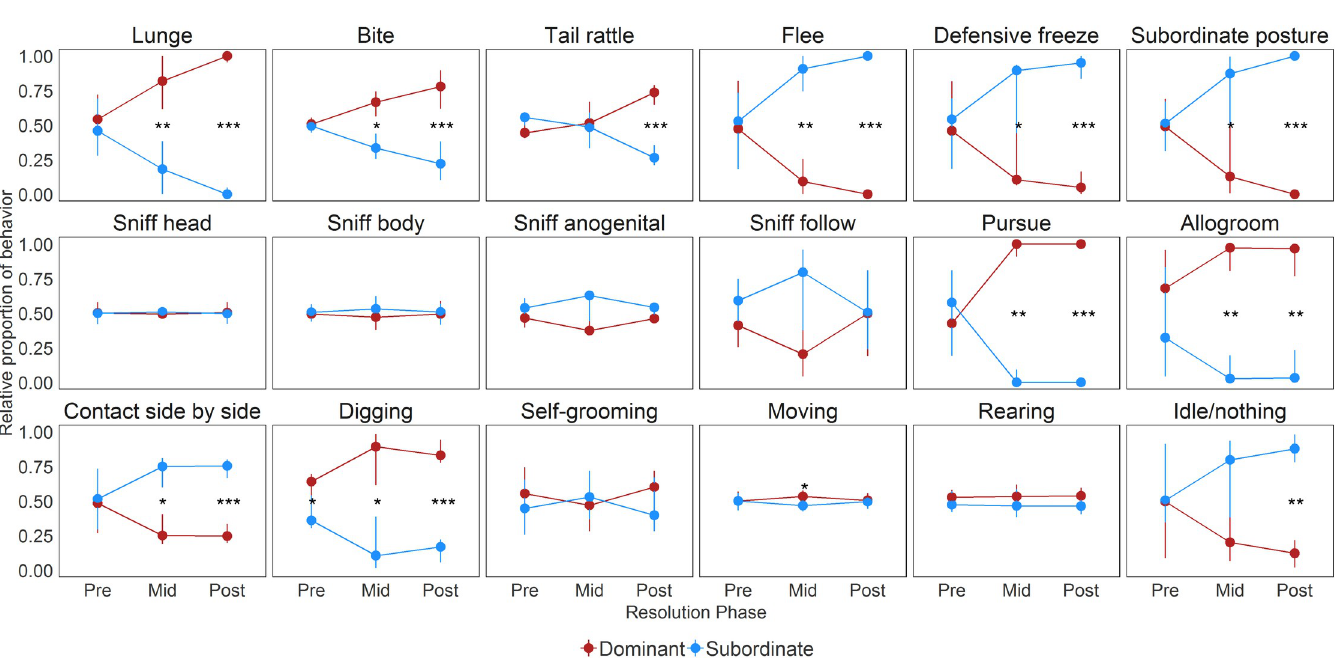
Fig 5. Relative proportion of time each behavior is exhibited the by eventual dominant (red) and subordinate (blue) mice during each phase. Data are medians ± IQRs. The asterisks indicate p-values from paired Wilcoxon Signed Rank Tests; � : p < 0.05, �� : p < 0.01, ��� : p < 0.001.